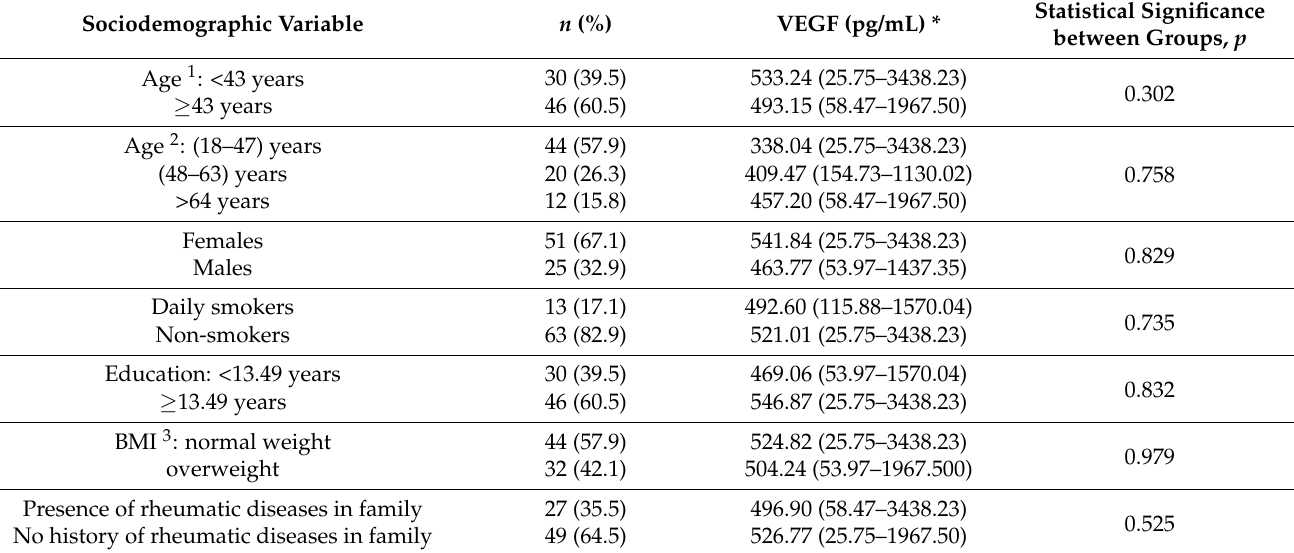
Table 5. VEGF level distribution between early undifferentiated arthritis sociodemographic parame- ters